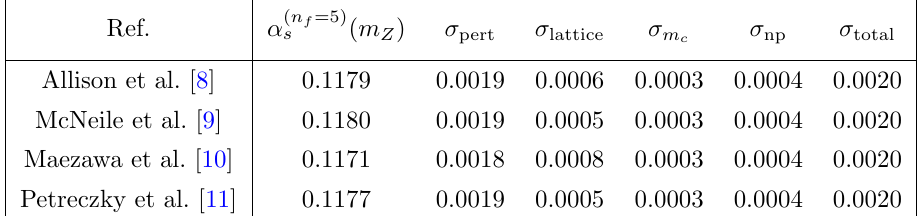
Table 9 . (cid:11) ( n f =5) s ( m Z ) determination from the n = 0 moment of the pseudo-scalar correlator M P; 0 . c The (cid:12)rst column shows from which reference the lattice results are taken, the second corresponds to the central value, third to sixth provide the various component of the uncertainty: scale vari- ation ( (cid:27) pert ), lattice ( (cid:27) lattice ), charm mass ( (cid:27) m ) and gluon condensate ( (cid:27) np ), which are added in c quadrature in the last column ( (cid:27) total